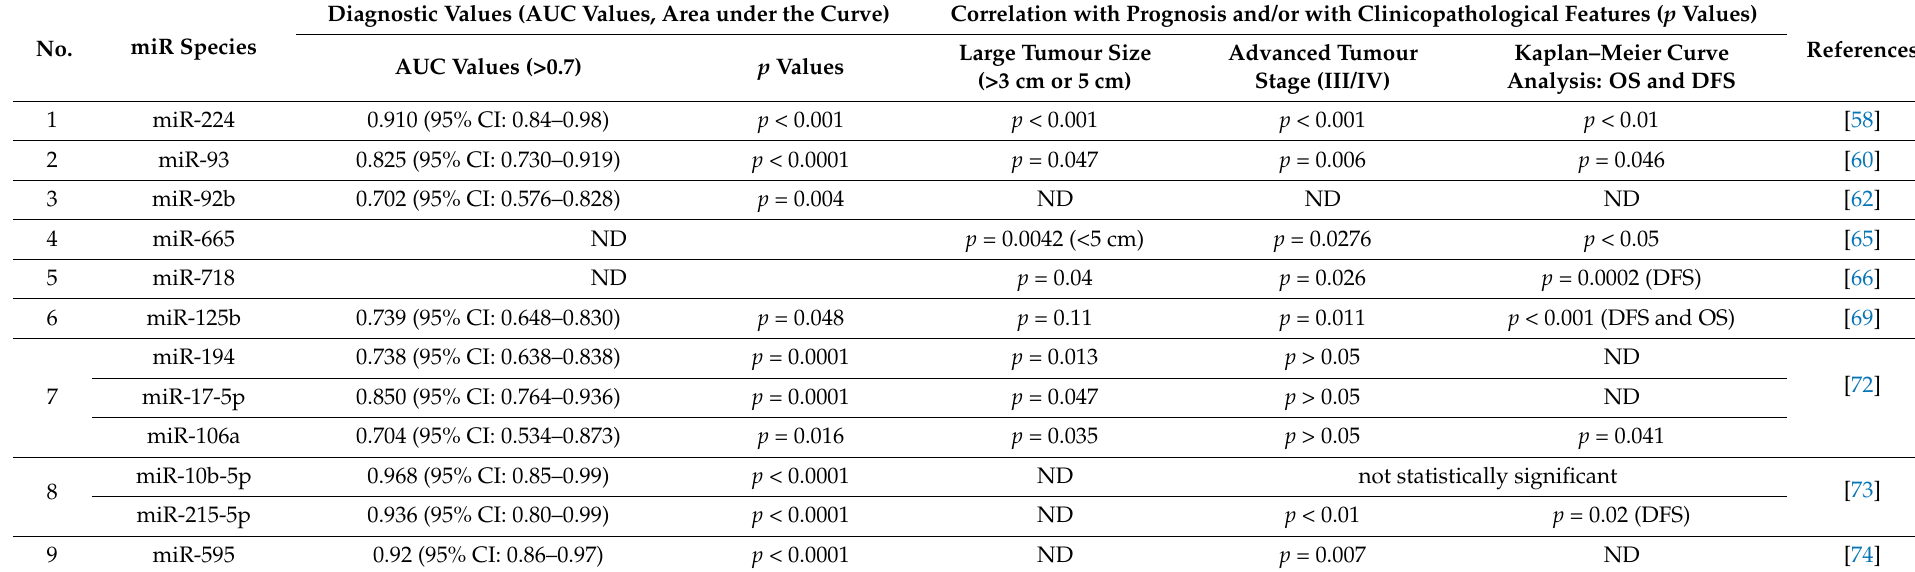
Table 2. Exosomal miRNAs with statistically significant expression with respect to clinical